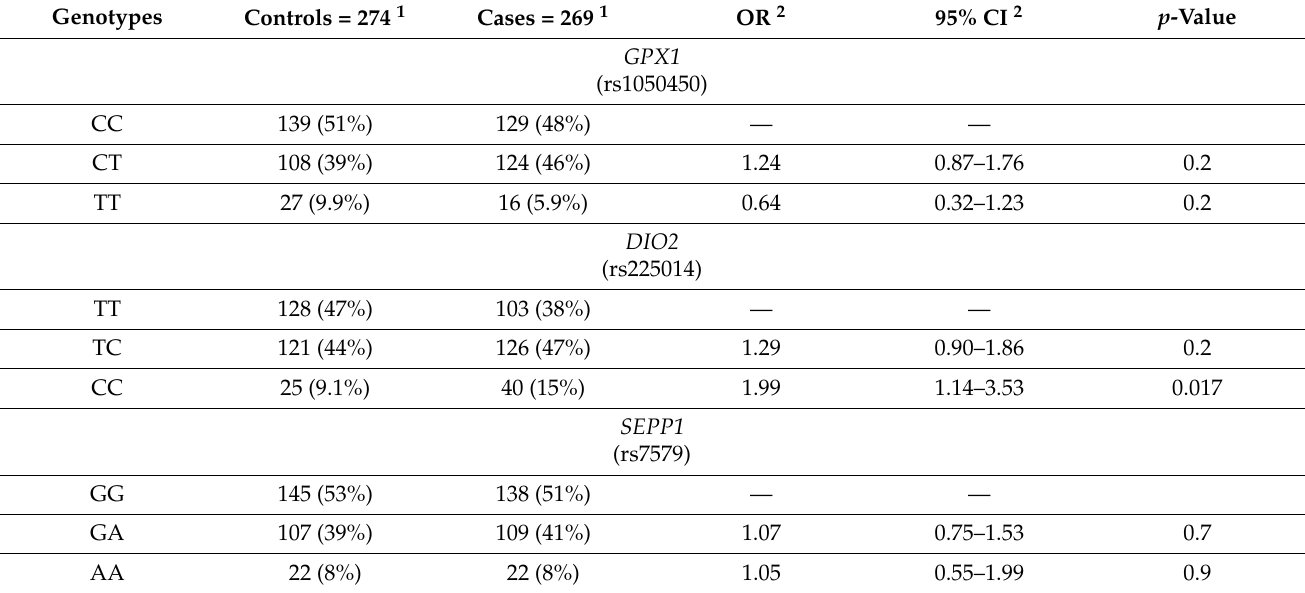
Table 1. The frequency of genotypes, the odds ratio and 95% confidence thresholds for selected gene polymorphisms: GPX1 , DIO2 , SEPP1